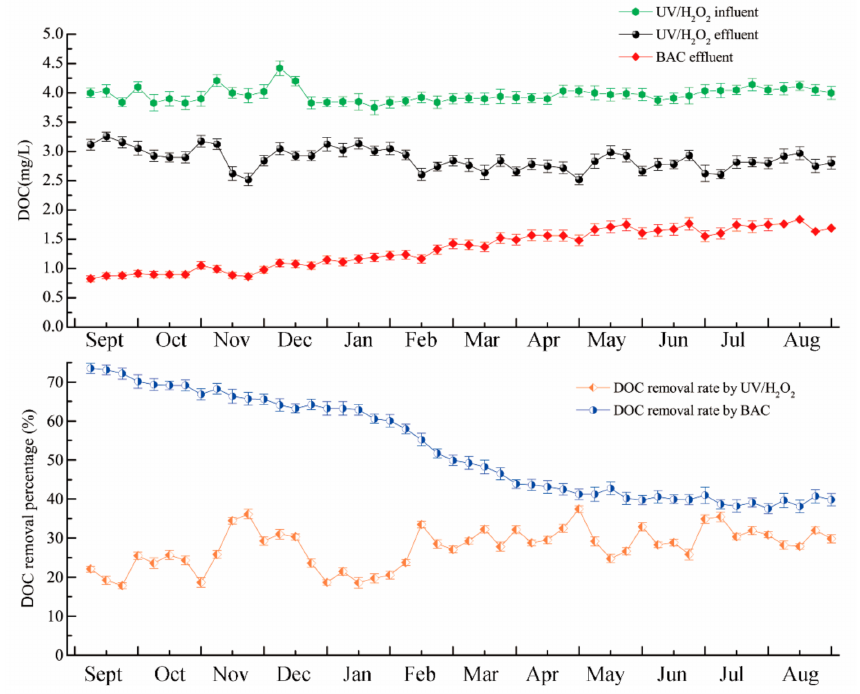
Figure 2. Dissolved organic carbon (DOC) removal of UV/H 2 O 2 -BAC